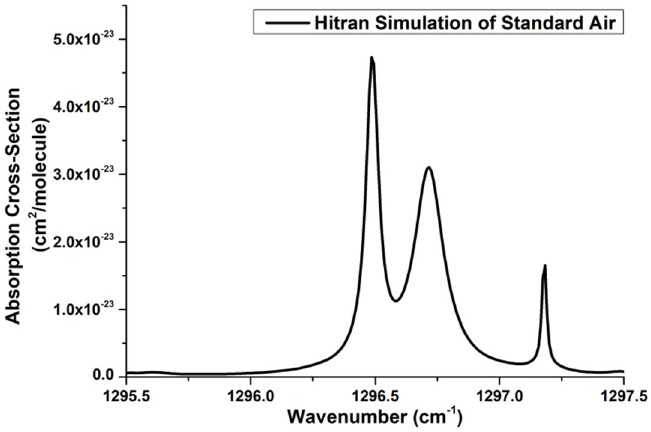
Figure 4. Absorption cross-section of standard air at 760 Torr.